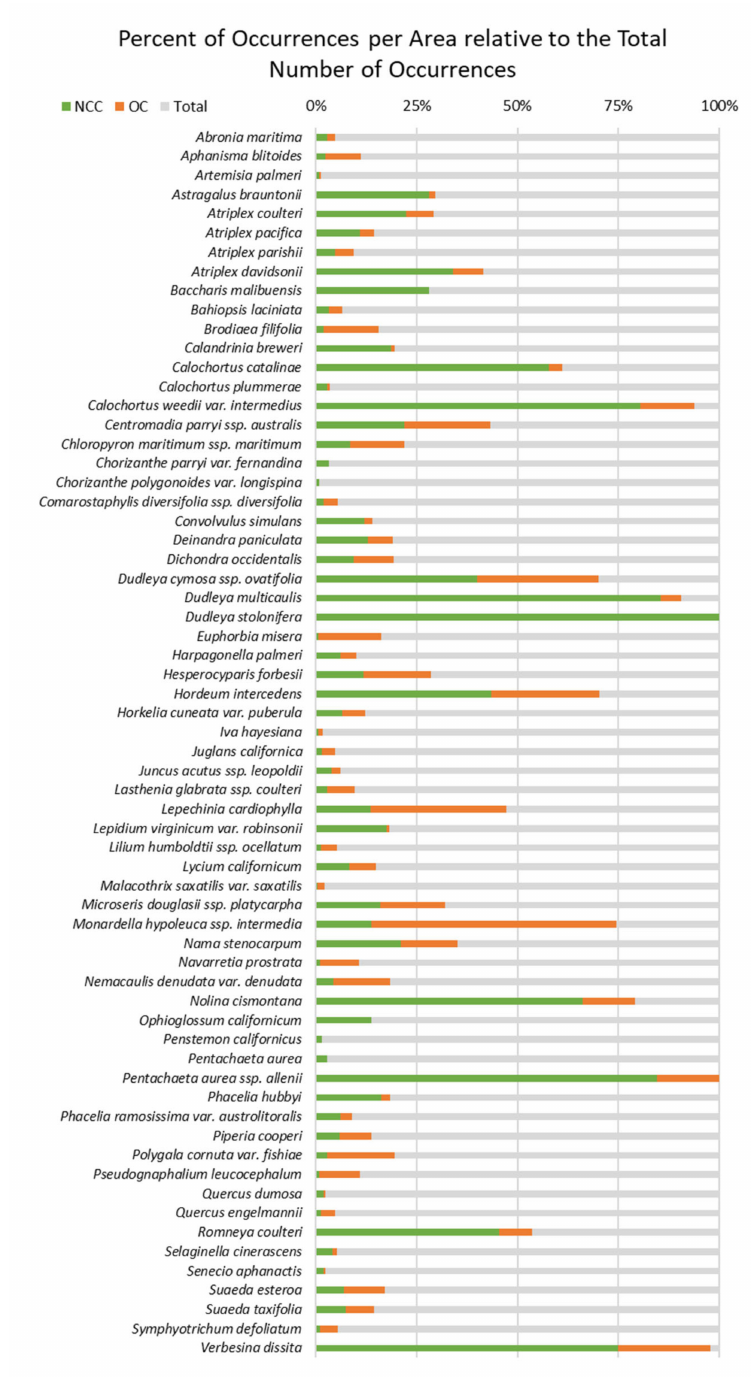
Figure A1. Percent of rare plant occurrences within the Natural Communities Coalition (NCC) Reserve System and Orange County relative to the total number of occurrences throughout a species’ range. All species in the NCC (green) are within Orange County (orange), with gray indicating species occurrences outside of NCC and Orange